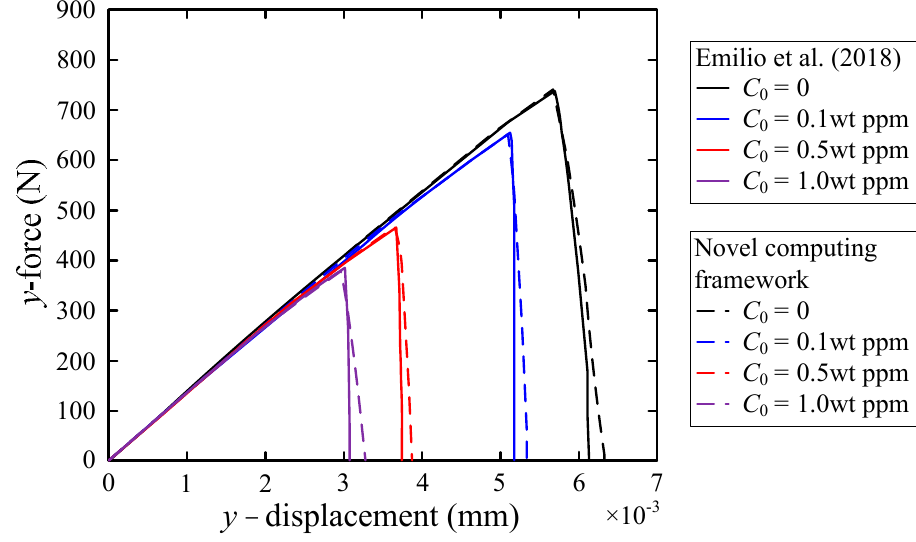
Figure 6. Load-displacement curves with different hydrogen concentrations.